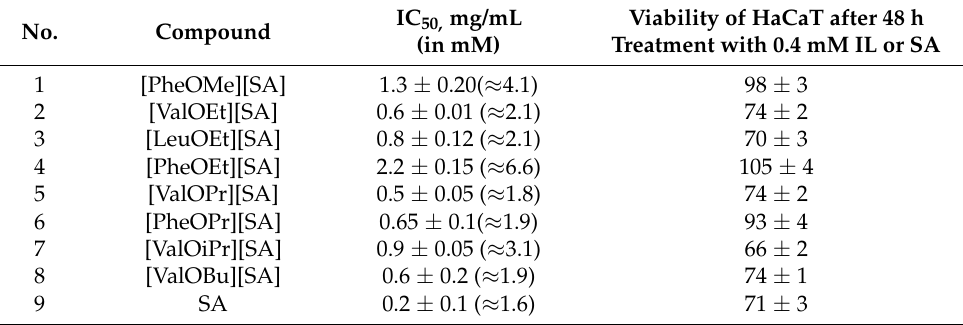
Table 5. Cytotoxicity of the tested compounds toward human keratinocytes (HaCaT cells). No. Compound